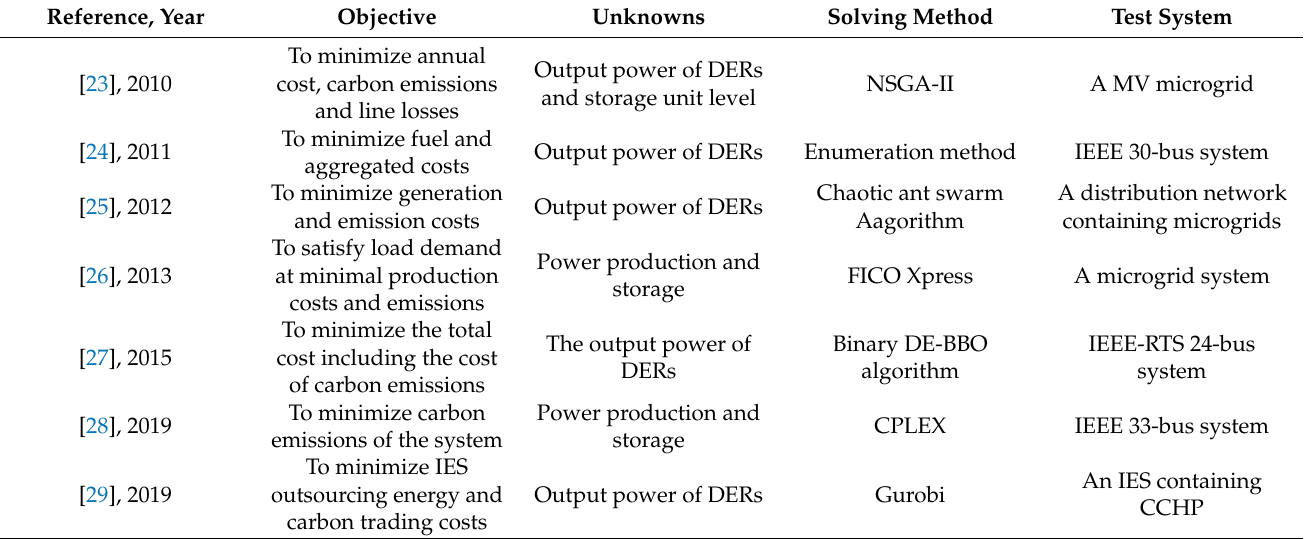
Table 1. Summary of related